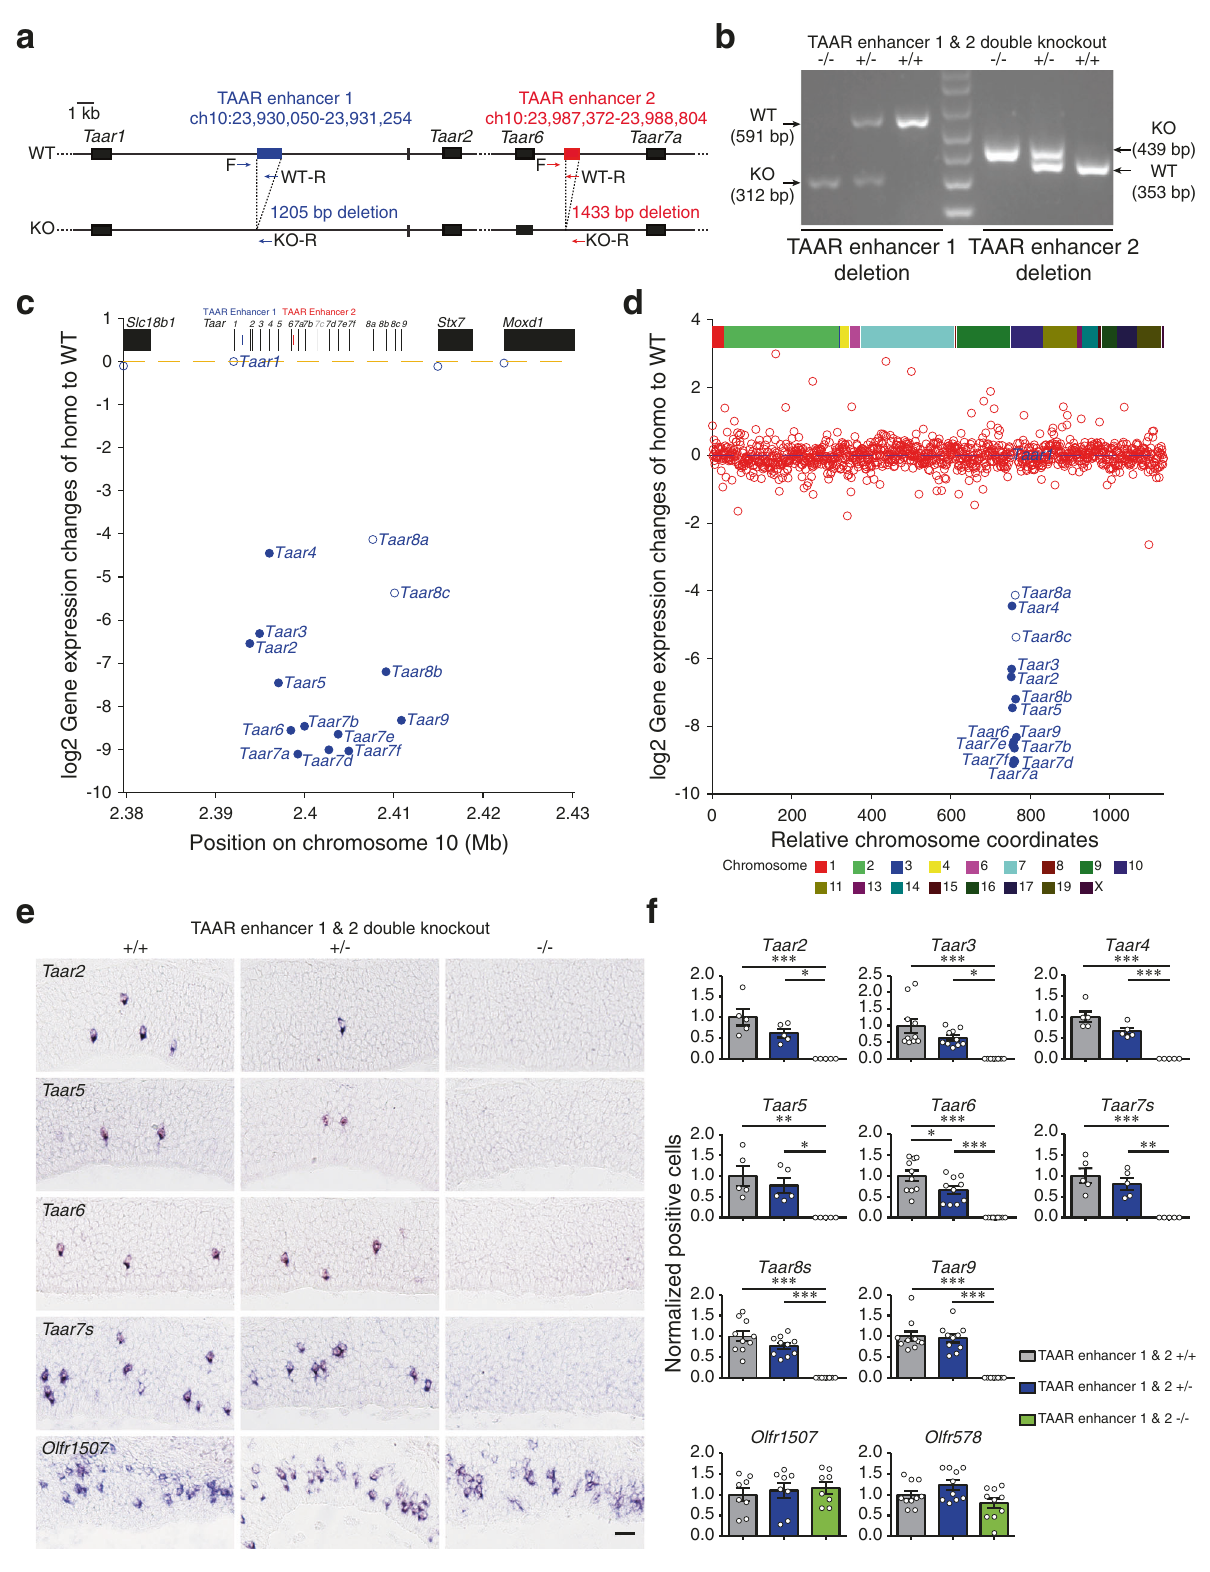
mice (Fig. 4e, f, h). In genotype 2 and 3 mice, cells expressing these Taar genes showed similar pattern to that in hetero- zygous TAAR enhancer 1 knockout and Taar2-9 cluster knockout mice (Figs. 4e, f and 8b, c and Supplementary Fig. 10a, b), whereas cells expressing these Taar genes in